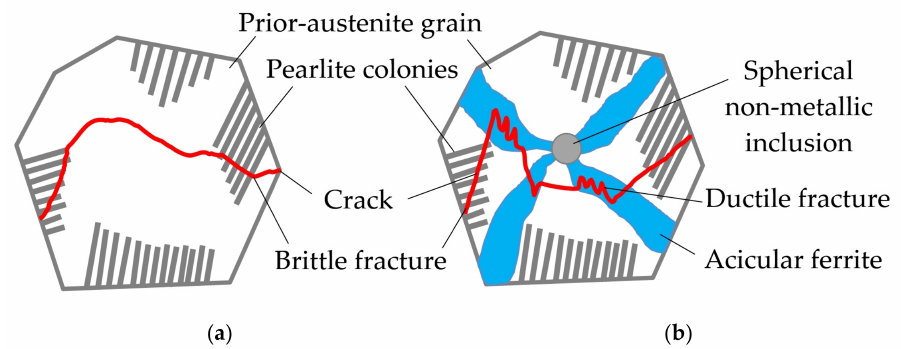
Figure 7. Cold crack propagation trajectory in prior-austenite grains: ( a ) without acicular ferrite; ( b ) with acicular ferrite nucleated on a spherical non-metallic inclusion.